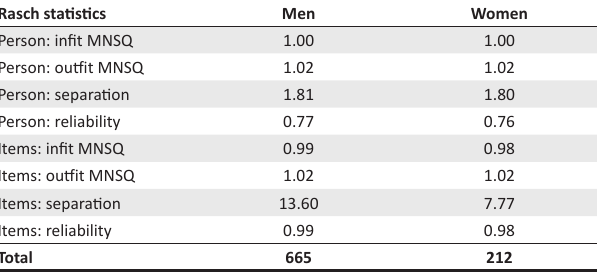
TABLE 3: Average fit statistics for men and women for English Comprehension Test version